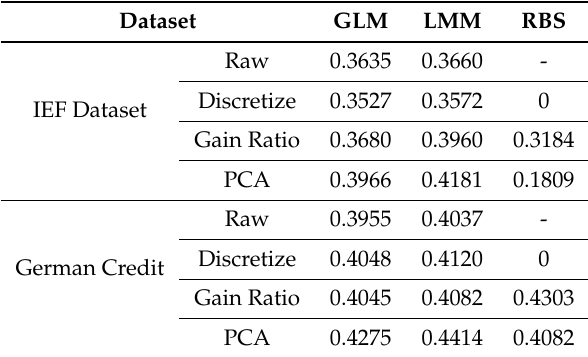
Table 5. Root mean square error